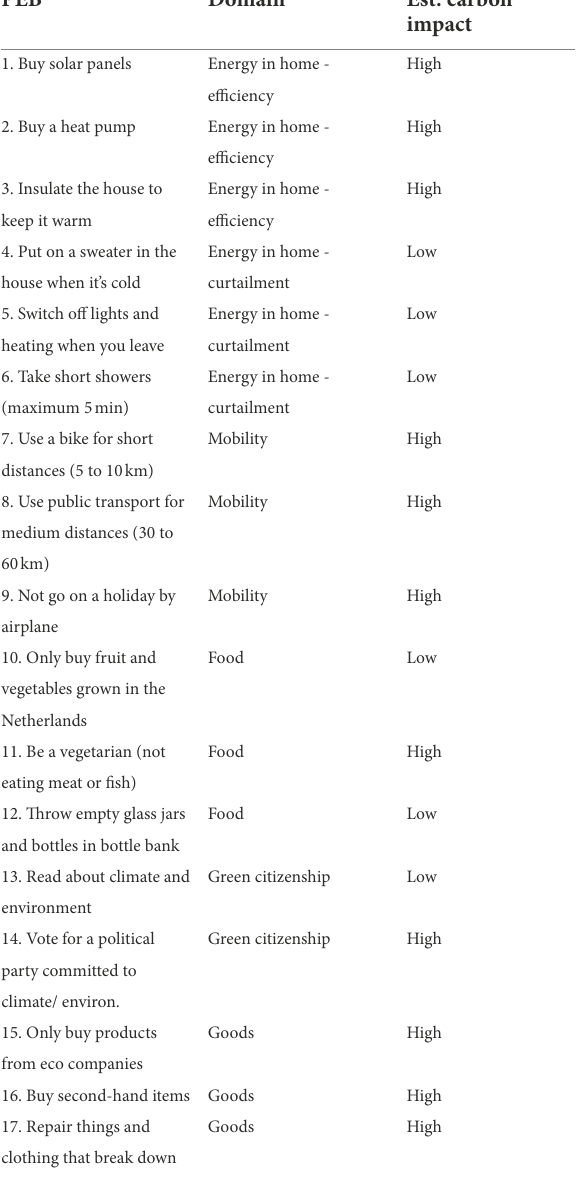
TABLE 1 17 PEBs per domain and with an estimated carbon emission